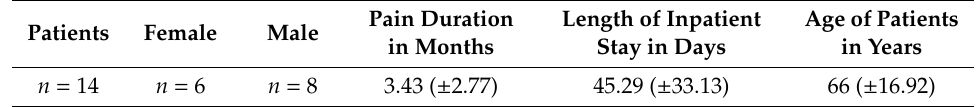
Table 1. Patients’ clinical data (mean values and standard deviations are shown).